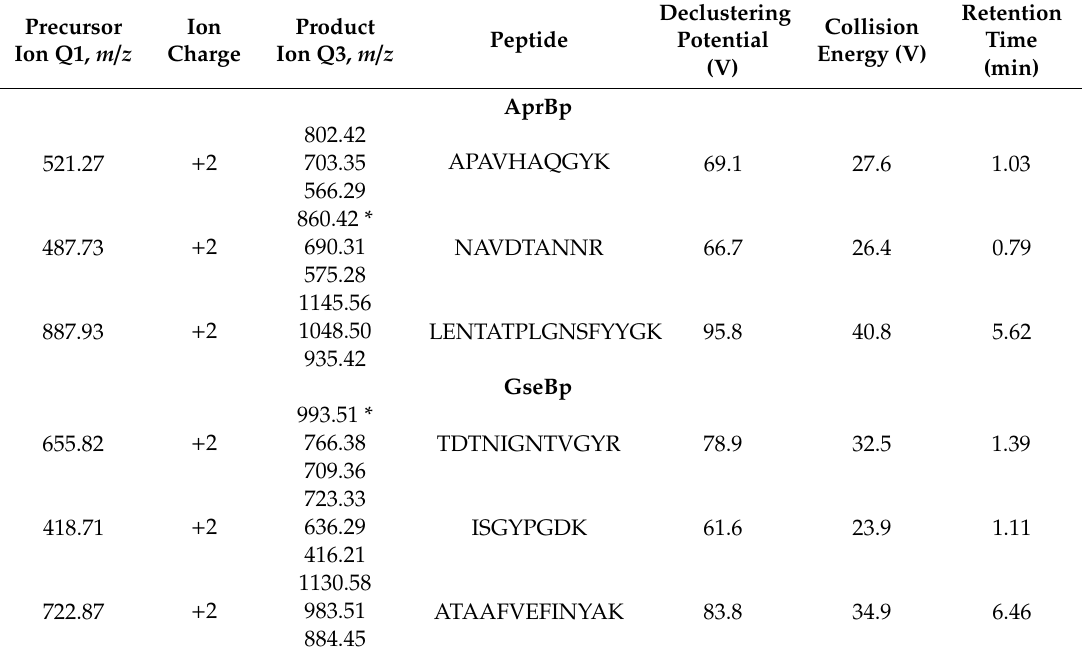
Table 1. Precursor ions and their transitions were used for final multiple reaction monitoring (MRM)